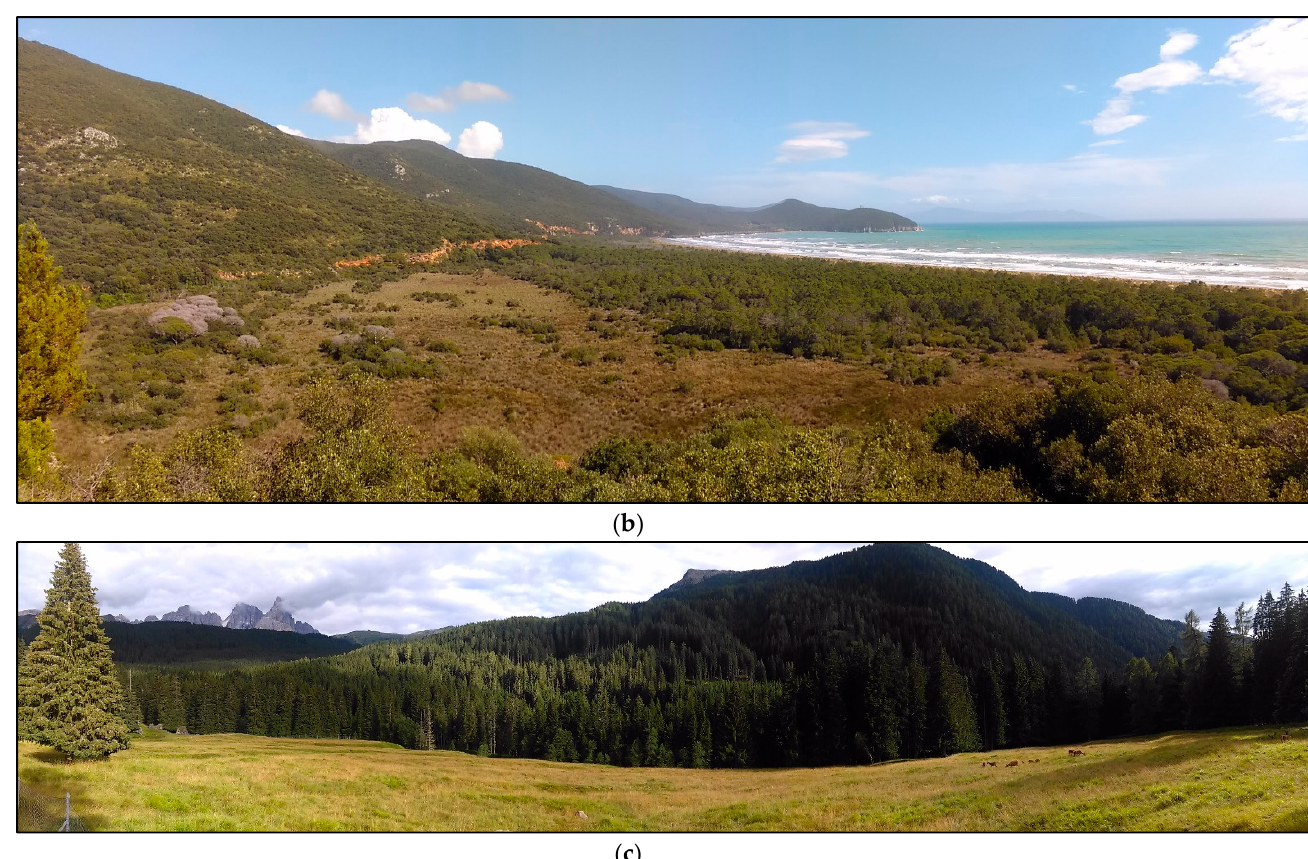
Figure A1. Pictures of woodland landscapes: ( a ) T1 Broadleaved Deciduous forest on Apennine chain (Photo by E. Agrillo); ( b ) T2 Broadleaved Evergreen forest along Tyrrhenian coast (Photo by E. Agrillo) and ( c ) T3 needleleaved forest habitat in the Alps range (Photo by E. Agrillo).